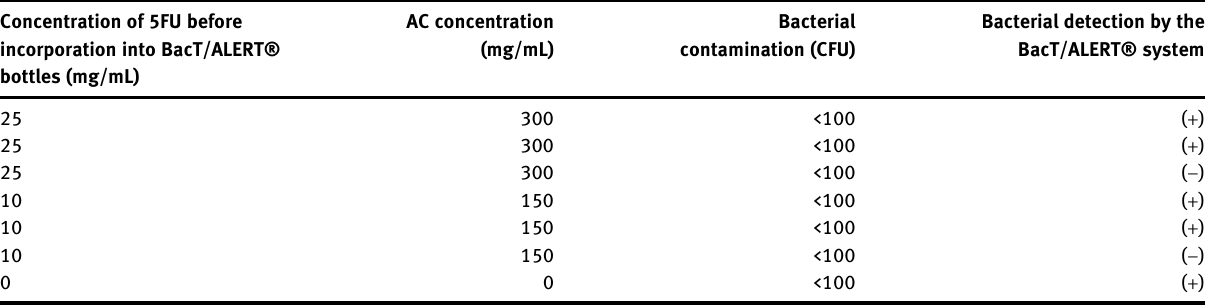
Table  : Bacterial growth from  FU solutions after AC treatment . Number of measures =  ; Format = m ± σ with m = percentage average and σ = standard